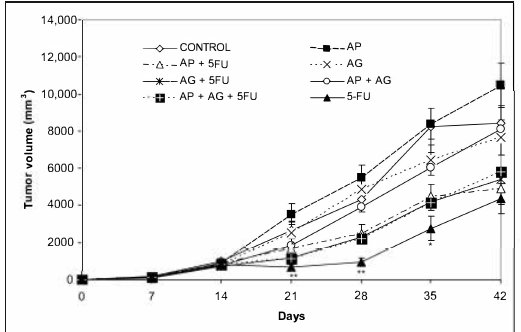
Figure 3. Changes in tumor volume of Balb / c mice after treatment with Agarikon Plus, Agarikon.1 and 5-fluorouracil in various combinations. Treatment started on day 14 after s.c. inoculation of CT26.WT (1 × 10 6 / mouse) cells. Volumes were determined once weekly for six weeks. * Significantly di ff erent (* p < 0.05; ** p < 0.01 in comparison with control group. Bars show means ±